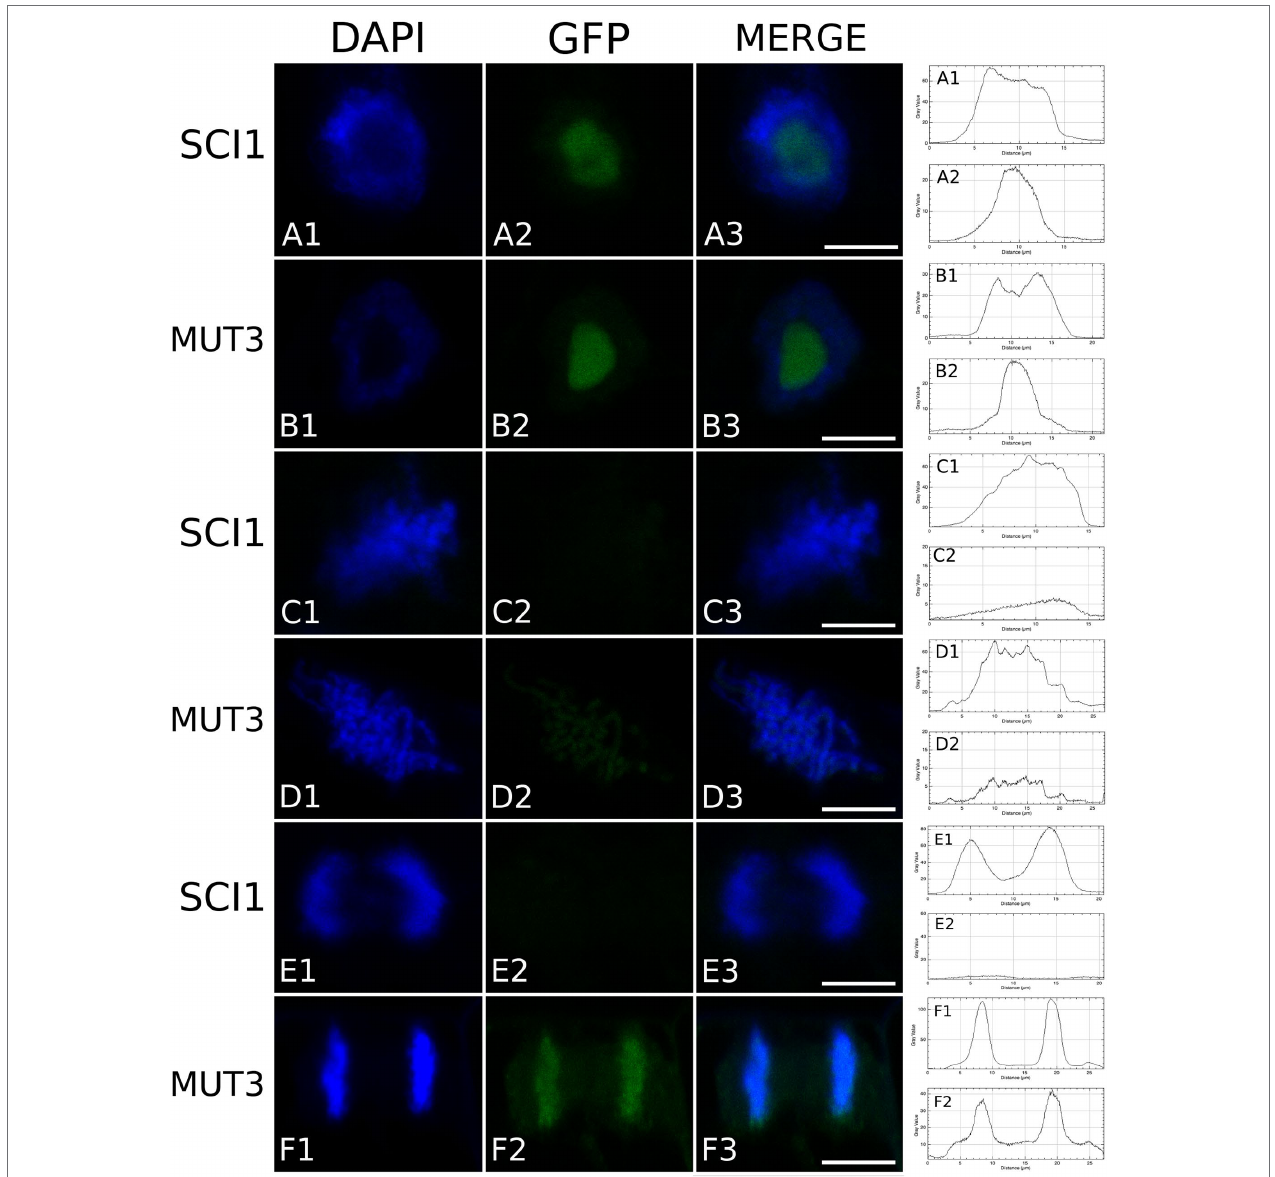
FIGURE 6 | A mutated version of SCI1 lacking seven serine residues is not degraded during cell division. Confocal microscopy images showing SCI1-GFP and SCI1mut3-GFP in different cell-cycle phases: interphase, metaphase, and anaphase. Tobacco BY-2 cells stably transformed with 35S prom ::SCI1-GFP and 35S prom ::SCI1mut3-GFP were stained with DAPI. Images were captured using Leica TCS SP5 (Leica Microsystems). Identical settings were used to compare fluorescence intensity, which was quantified and is shown on the graphics at right (two graphics for each line of cells). The first graphic (above) refers to the DAPI image’s fluorescence, while the second graphic (below) represents the GFP fluorescence. Scale bars 7.5 μ